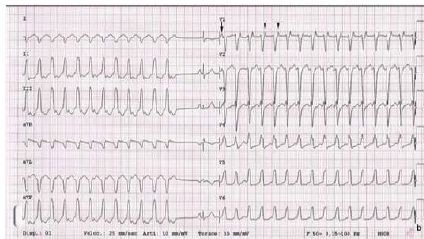
Figure 1: VT in LBBB morphology and inferior QRS axis. The first arrow points to a dissociated P wave in V1; then retrograde conducted 1 :1 P waves follow (arrowheads).